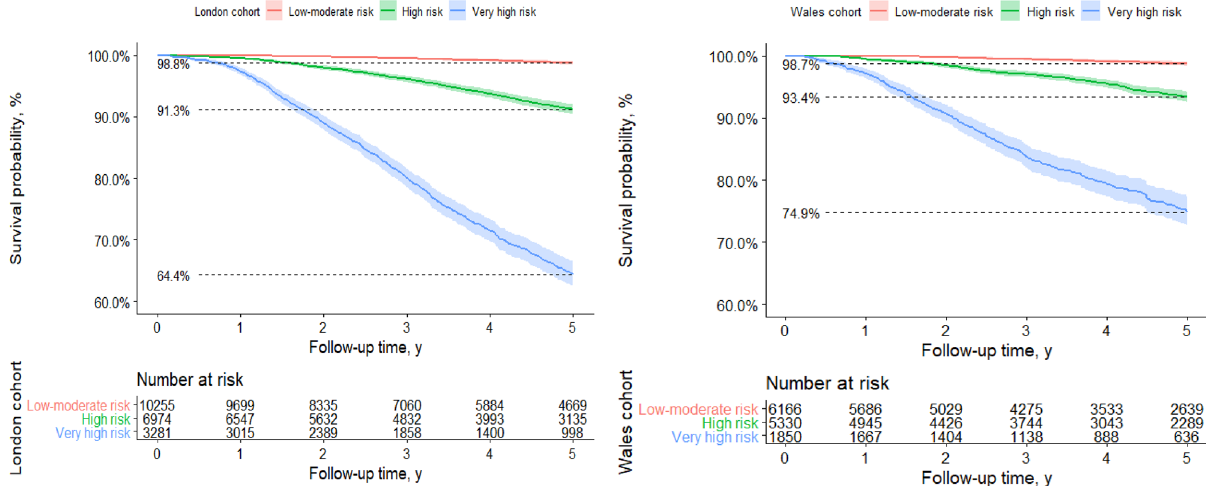
Figure 3. Kaplan–Meier curves stratified by risk groups according to model predictions. This figure shows observed probabilities over time in the derivation and validation datasets by risk group according to predictions from the minimal resources model. The prognostic groups were defined by categorising the linear predictor according to the cut-points representing the 50th and 84th centiles, equivalent to LP(linear predictor) values of: ≤ 0.72, > 0.72 and ≤ 2.36, > 2.36 or predicted risks of ≤ 3.6%, > 3.6% and ≤ 17.2%, >